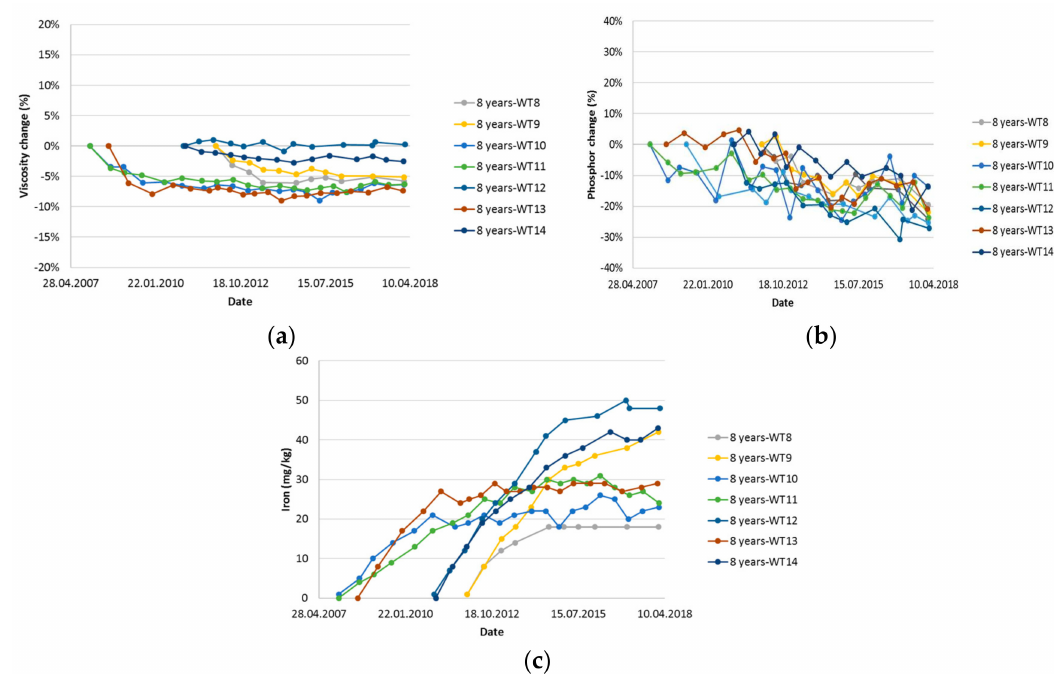
Figure 9. Trend analysis for the eight-year turbine group with PAO I. ( a ) Changes in the kinematic viscosity; ( b ) changes in the phosphorus content measured by the ICP method; ( c ) iron content measured by the ICP method.